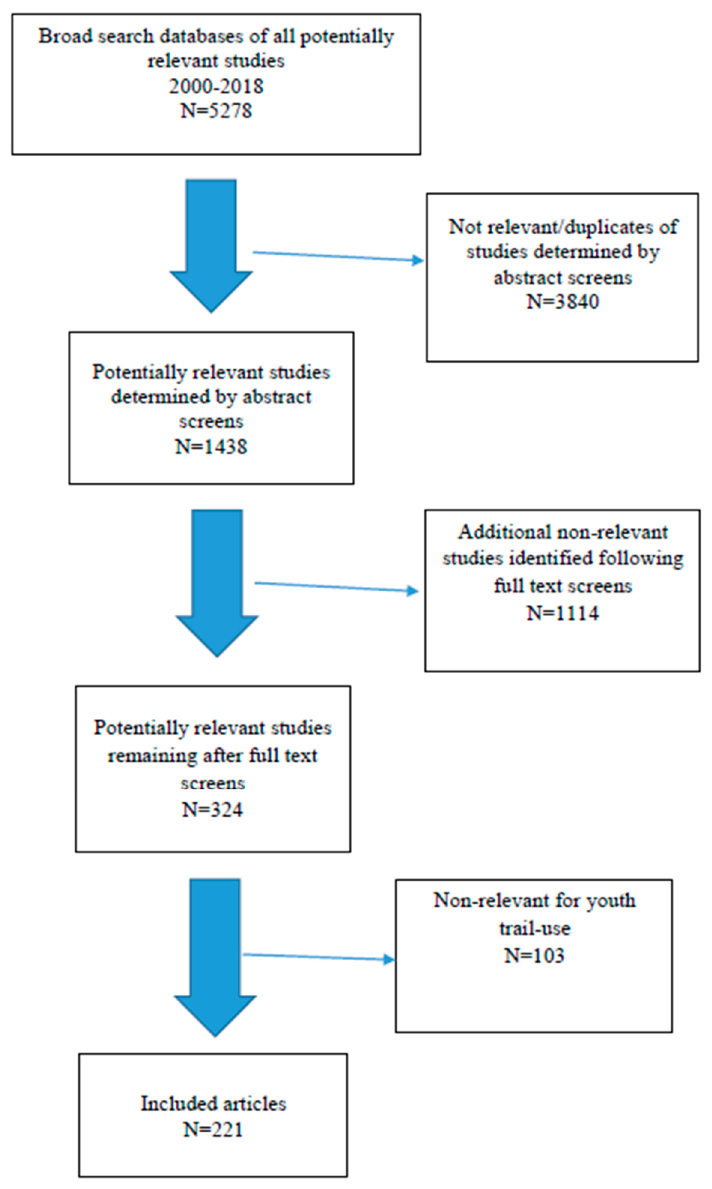
Figure 1. Flowchart of inclusions/exclusions for articles selected for review.